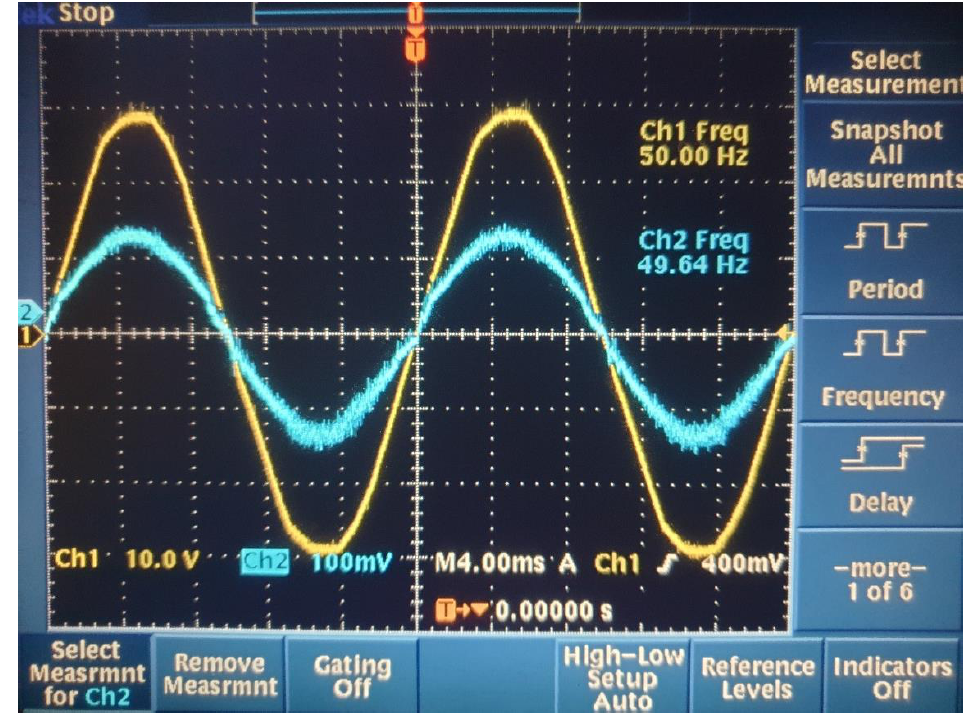
Figure 16. voltage and current in phase a , of the prototype. Figure 16. Voltage and current in phase a , of the prototype.